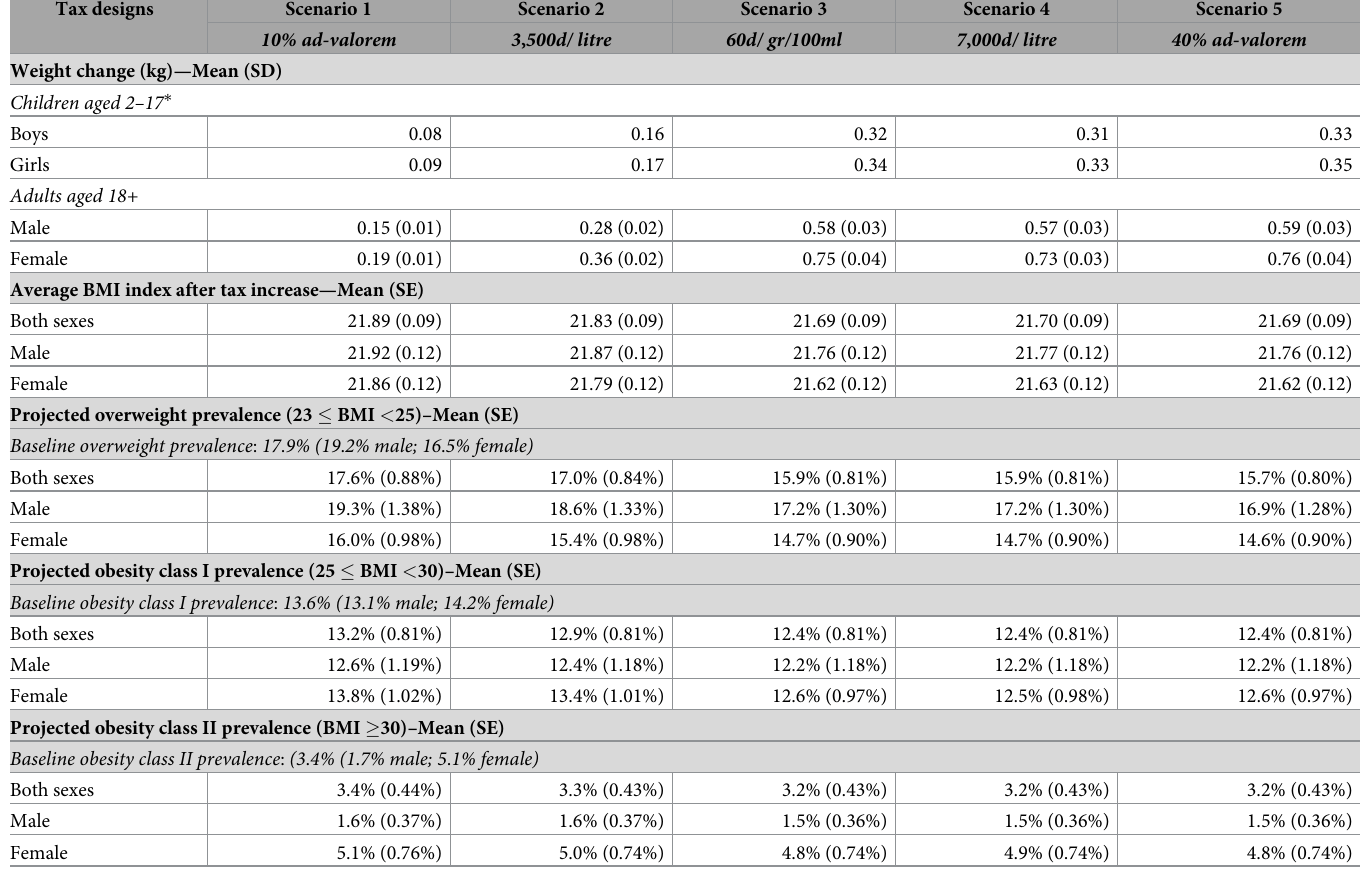
Table 4. Estimated weight changes and BMI index after 3 years of tax